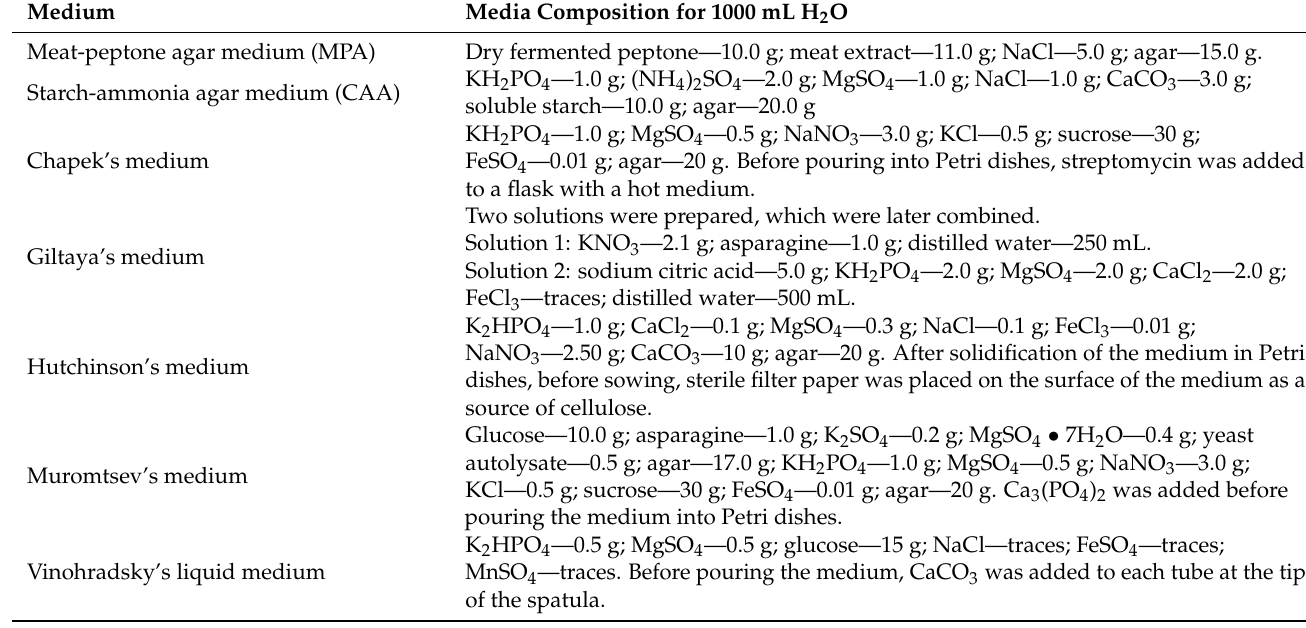
Table 2. Media composition used for microbiological